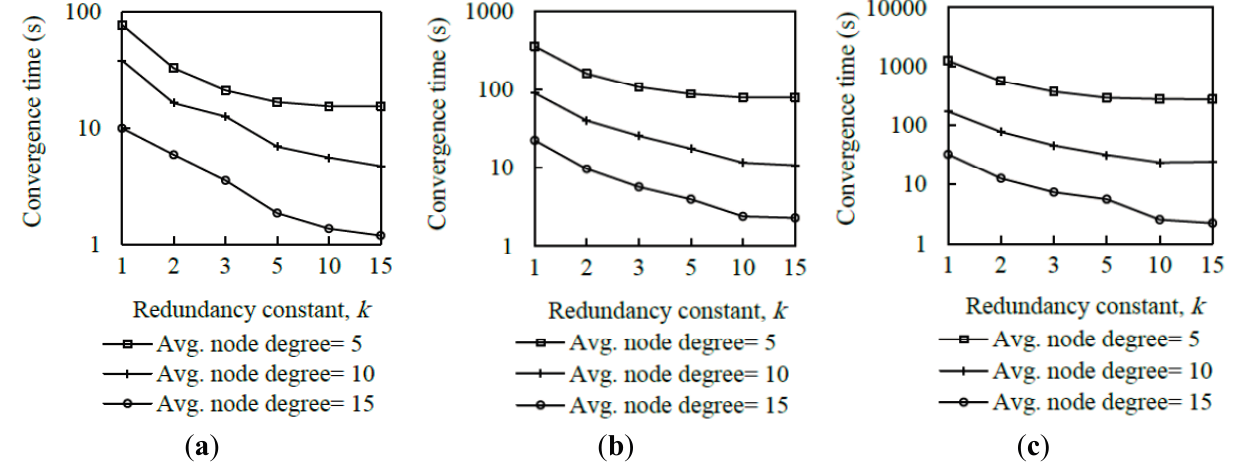
Figure 4. Average network convergence time in three network size scenarios, for different densities, as a function of the redundancy constant, k : ( a ) Small network scenario, ( b ) medium network scenario, and ( c ) large network scenario,